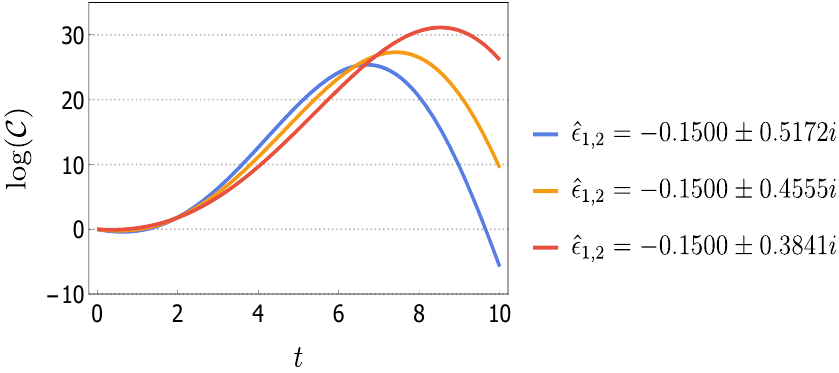
Figure 8 . Evolution of Complexity for a K = 2 parameter system with a variation of eigenvalue of Encoder-Dataset tensor A ∞ in a non-chaotic regime. The non-zero complex part of the eigenvalues of A ∞ gives rise to the oscillatory behavior of the